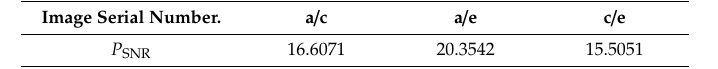
Table 1. The first set of data gray images mutual P SNR values.